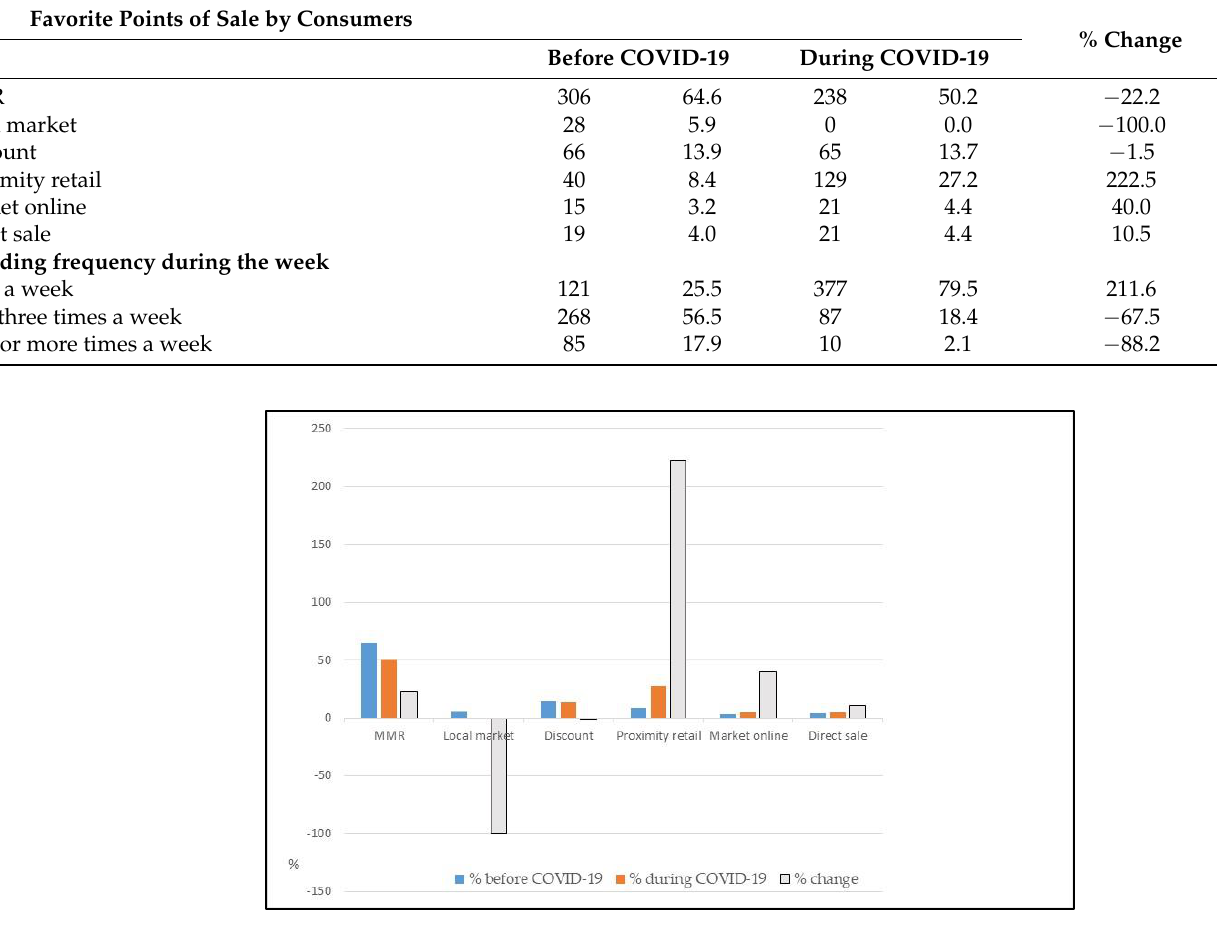
Figure 3. Changes in choosing the stores before and during COVID-19 Source: The authors.